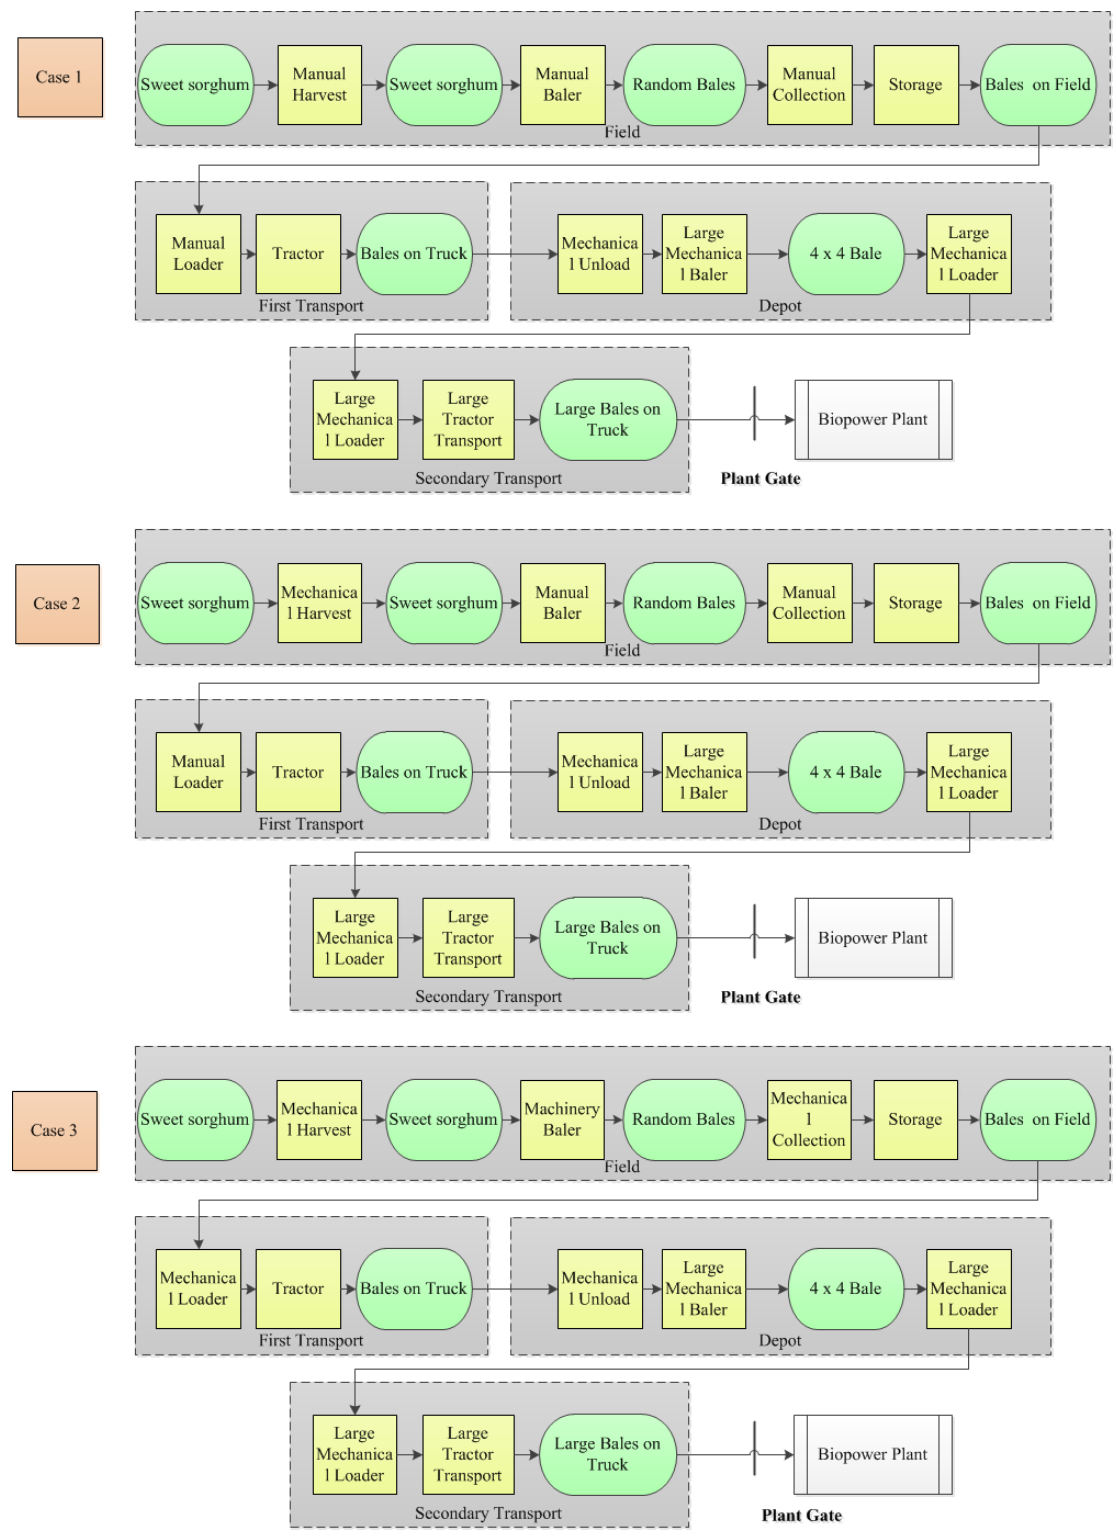
Figure 3. BLM-SinoFS process flow assumptions based on existing sweet sorghum stalks agricultural systems that are common throughout much of rural Inner Mongolia